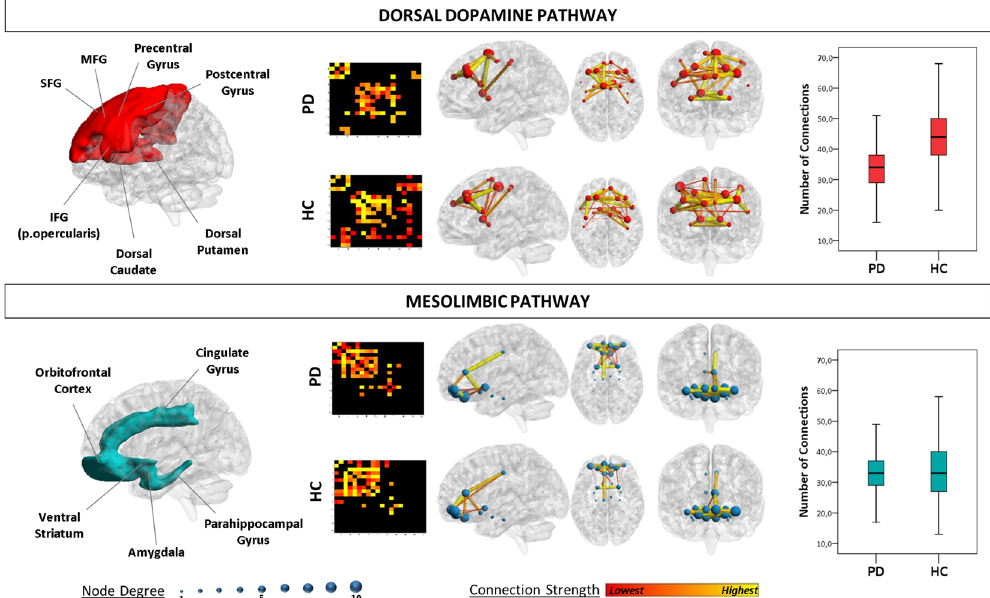
Figure 2. Dopaminergic networks analysis. Figure shows the cortical and subcortical projections of the main dopaminergic pathways (left panel). The dorsal dopamine pathway is affected in PD, showing loss of connectivity and reconfiguration. The mesolimbic pathway is spared, with the overall number of connections in the pathway being preserved. Node degree, i.e. the number of connections for each region, is represented by the size of each dot. Connection strength is represented by the colour and thickness of each line connecting two nodes. Abbreviations: SFG: Superior Frontal Gyrus; MFG: Middle Frontal Gyrus; IFG = Inferior Frontal Gyrus. Box plots (right panel) show the total number of connections in each dopaminergic pathway, for PD and HC. Difference is significant for the dorsal dopamine pathway (p < 0.001).